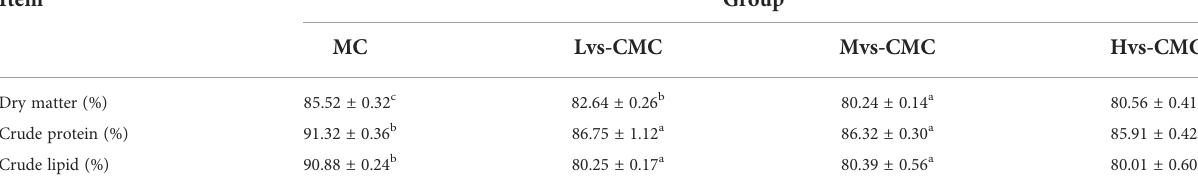
TABLE 4 Effects of increasing dietary viscosity on the dietary apparent digestibility of juvenile largemouth bass. Item